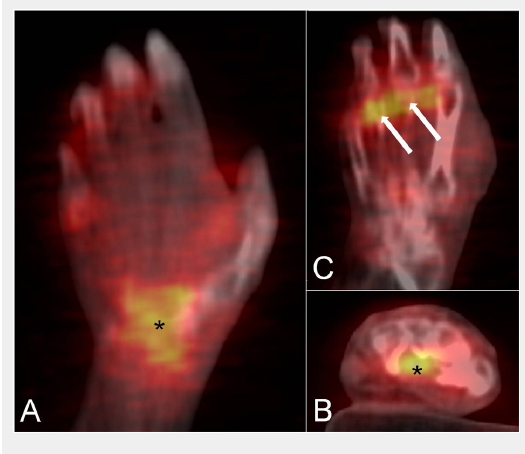
Two sequential PET/CT fused images of the knee in a patient with rheumatoid arthritis showing diffuse F18-FDG uptake in the medial and lateral paracondylar recesses (asterisks).